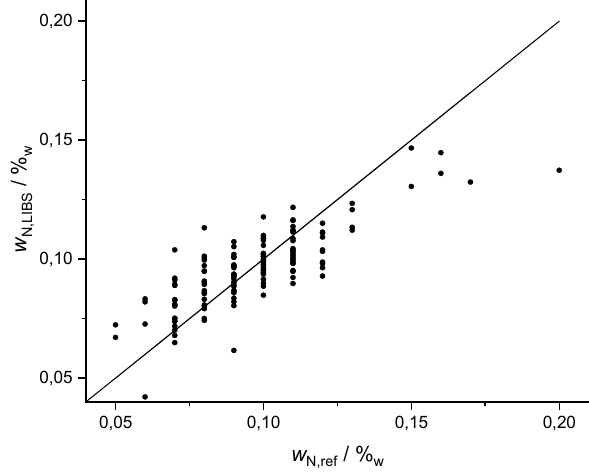
Figure 4. Results of 10-fold Lasso cross validation for nitrogen, R 2 (N, Lasso) = 0.65, reference data of nitrogen is coarsely resolved (in classes of Δ 0.01%).